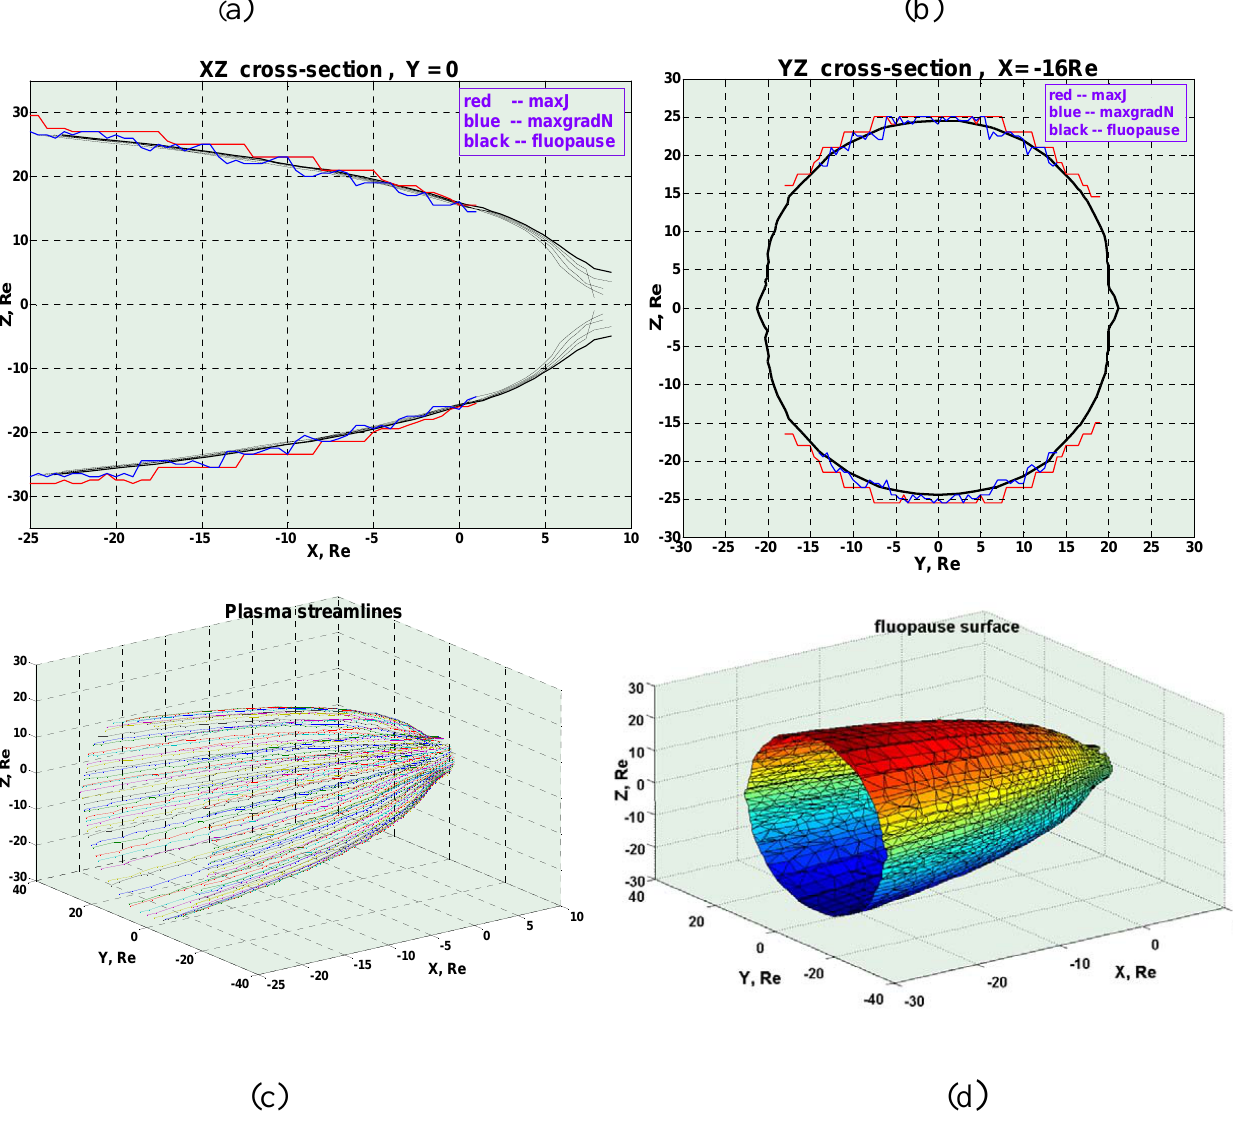
Fig. 2. The positions of magnetopause surfaces, corresponding to different definitions, in the XZ cross-section for Y =0 R E (a) and YZ cross-section for X = − 16 R E (b) ; plasma streamlines (c) and fluopause surface (d) .